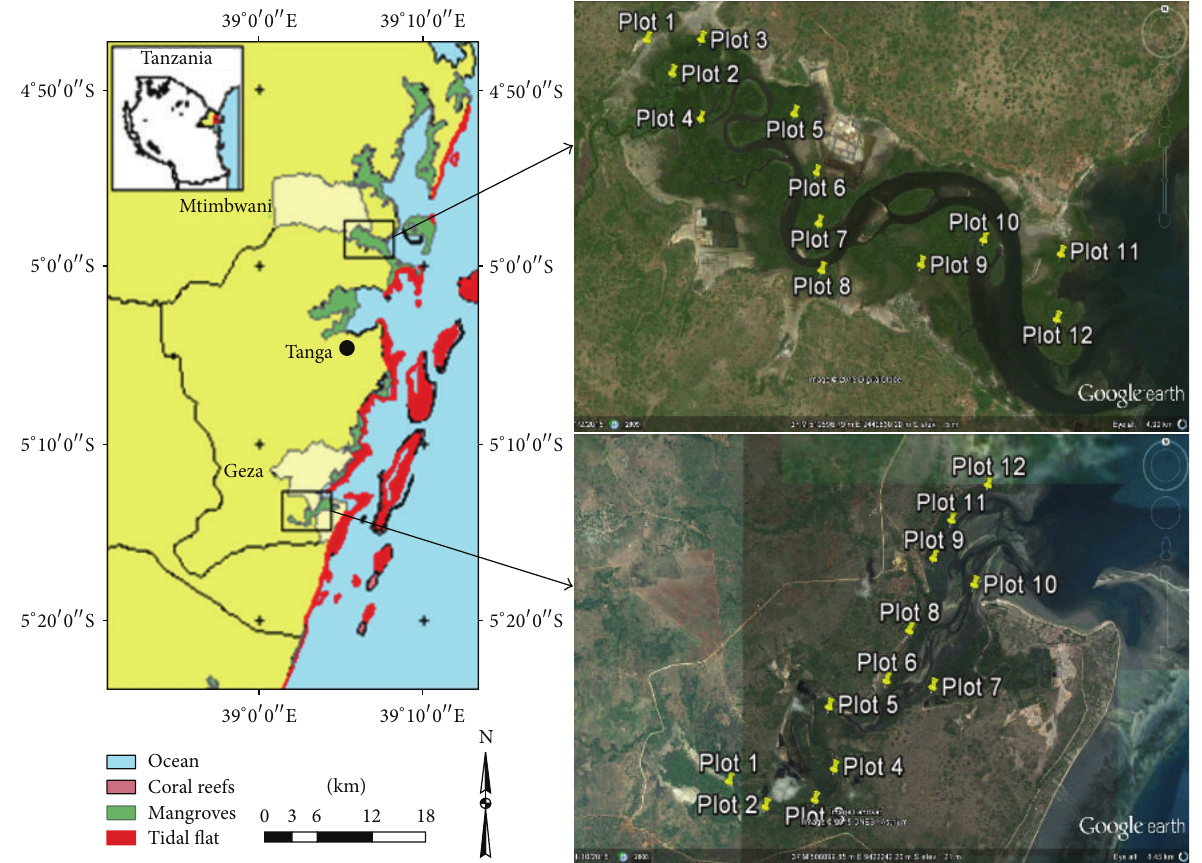
Figure 1: Map and Google Earth snapshots showing study sites and sampling plot